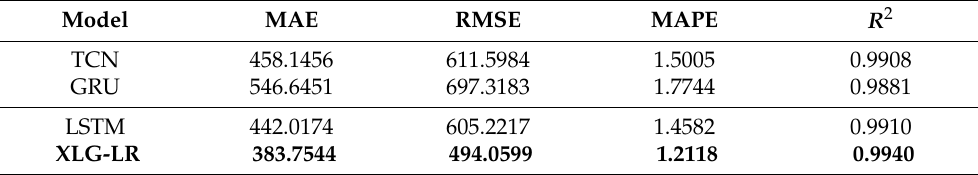
Table 8. Power Demand Forecasting of Different Models on a Weekly Basis.